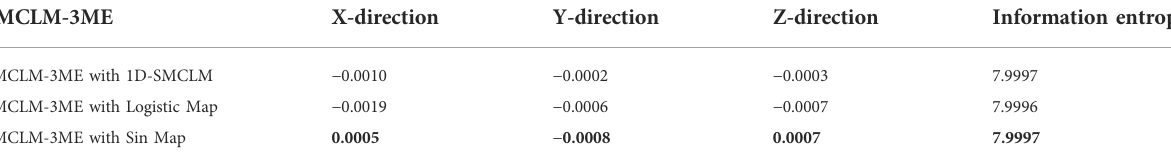
TABLE 10 In fl uence analysis of 1D-SMCLM in